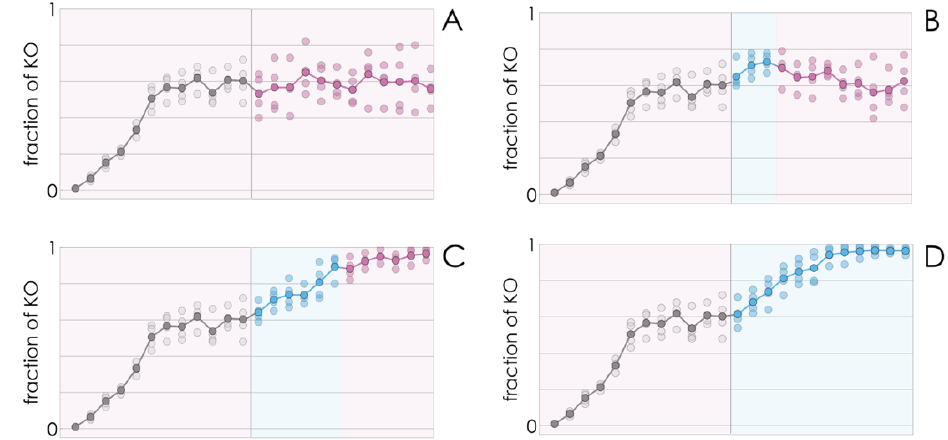
Figure 3. A transient increase in the amount of FBS can lead to stable collapse of cooperation. βTC cells (WT) coexist with β TC- ∆ IGF2 (KO) cells after about 6 passages with 5% FBS (gray dots—see Figure 1). ( A ) The population remains mixed for 18 passages. ( B ) If FBS is increased to 10% for only three passages, the KO clone slightly increases in frequency, but the population then returns to the original mixed equilibrium ( C ) If FBS is increased to 10% for six passages, the KO clone increases in frequency even after FBS is reduced to 5% and drives the WT clone to extinction. ( D ) If FBS is